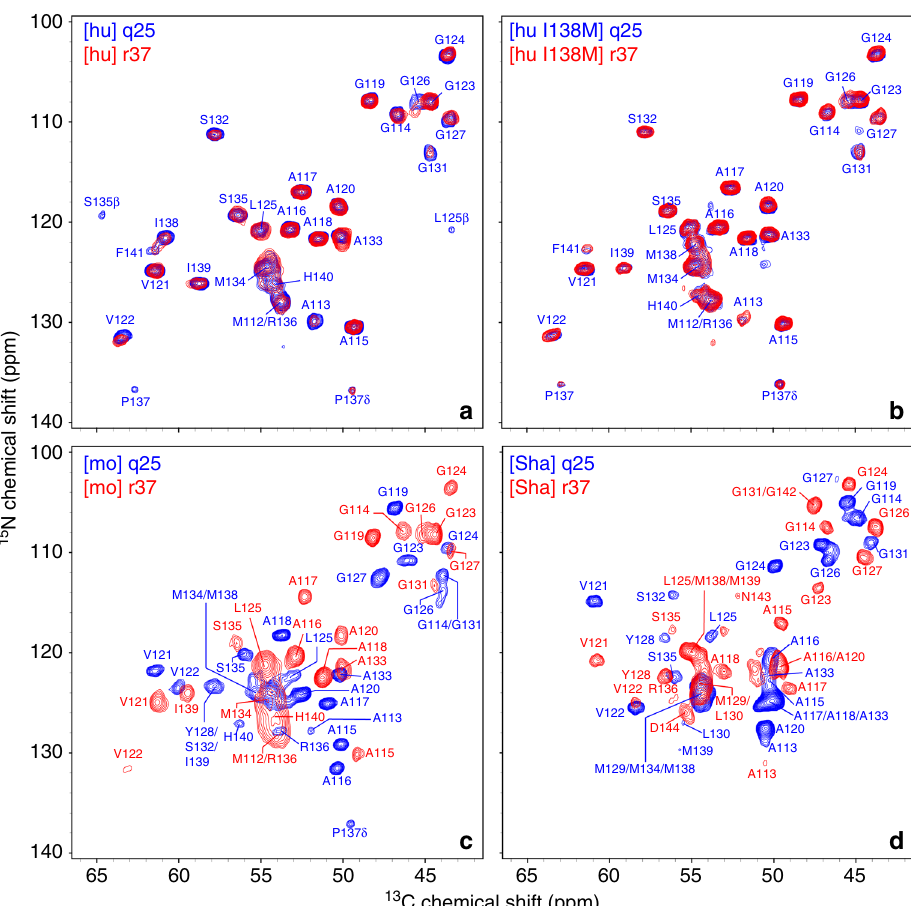
Fig. 4 15 N – 13 C α solid-state NMR spectra of PrP23-144 fi brils generated at 25 °C under quiescent conditions and at 37 °C with rotation. Assigned two- dimensional 15 N – 13 C α fi ngerprint solid-state NMR spectra are shown for q25 ( blue contours ) and r37 ( red contours ) amyloid fi brils as indicated in the insets for a hu, b hu I138M, c mo, and d Sha